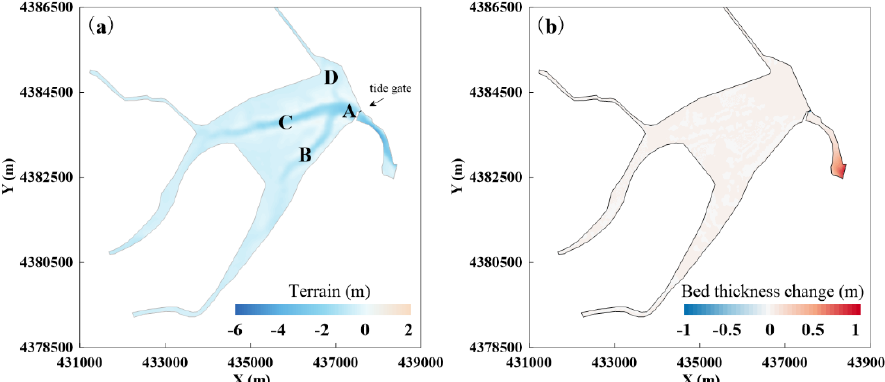
Figure 9. ( a ) Bathymetric map of QL system on 1 January 1980; ( b ) bed thickness change from 1970 to 1979 for the QL system.